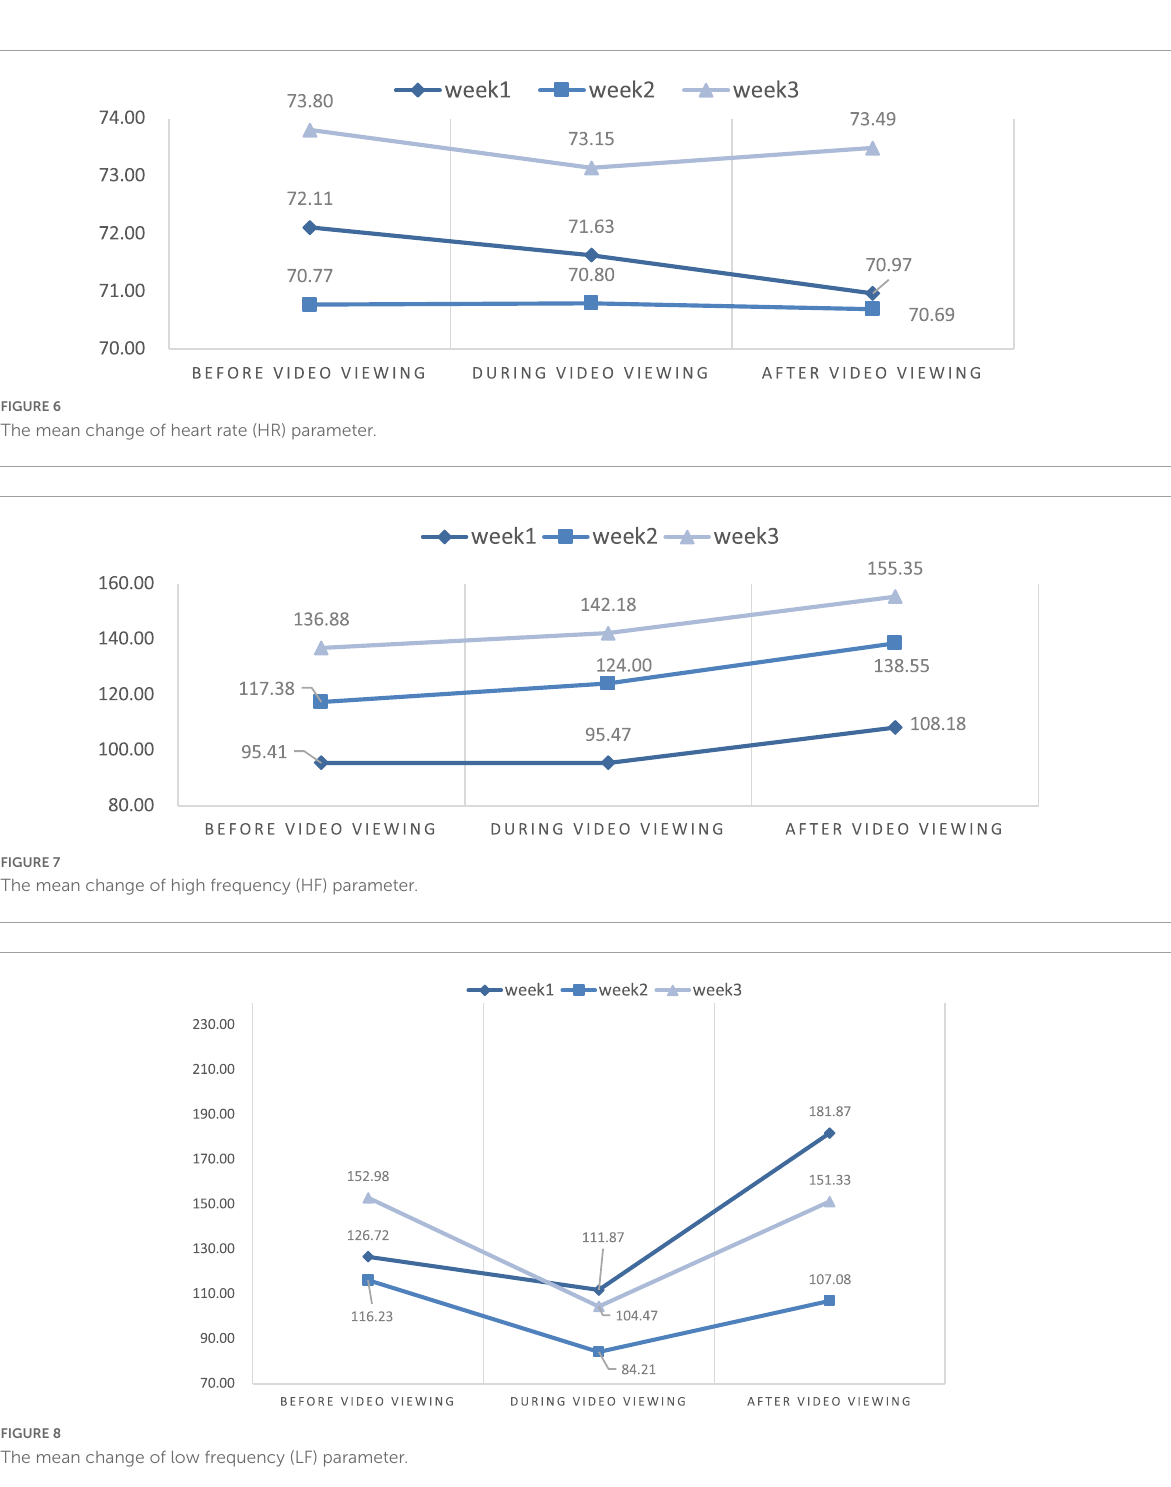
FIGURE8 The mean change of low frequency (LF)